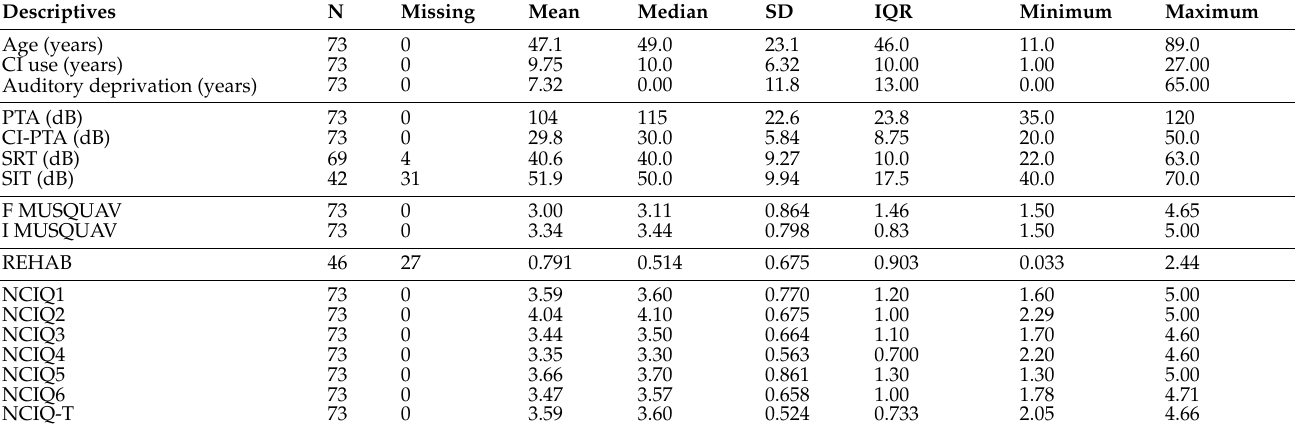
Table 1. Clinical features, audiological outcome, and PRO measures of the included